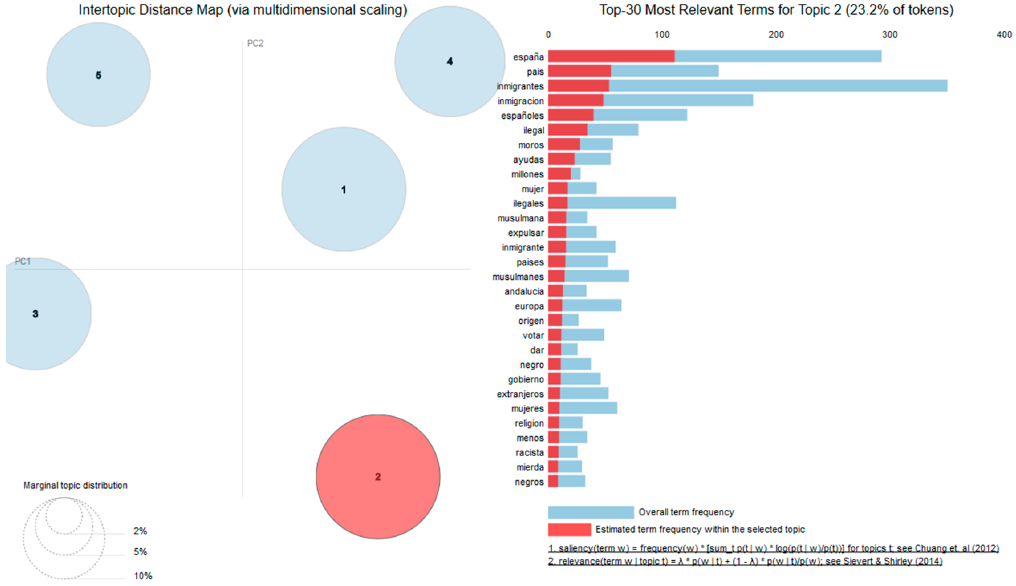
Figure 5. Interactive map of topic 2, ƛ = 1.